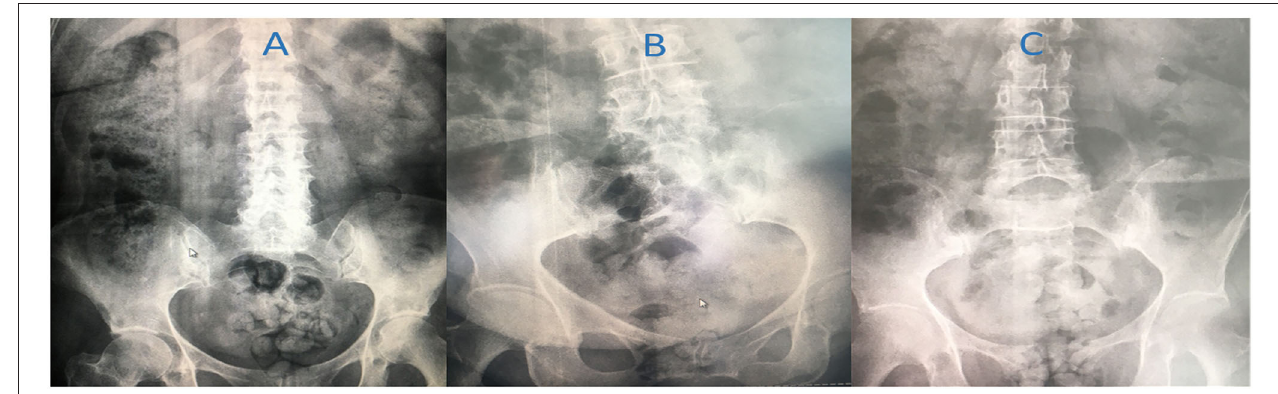
FIGURE 2 | Examples of fecal retention in this cohort. (A) severe fecal retention with impaction in a 68-year-old woman with motor fluctuations reporting moderate improvement following therapy, (B) pan-colonic fecal retention in an 80 year-old woman with severe dyskinesia, improving following therapy (see